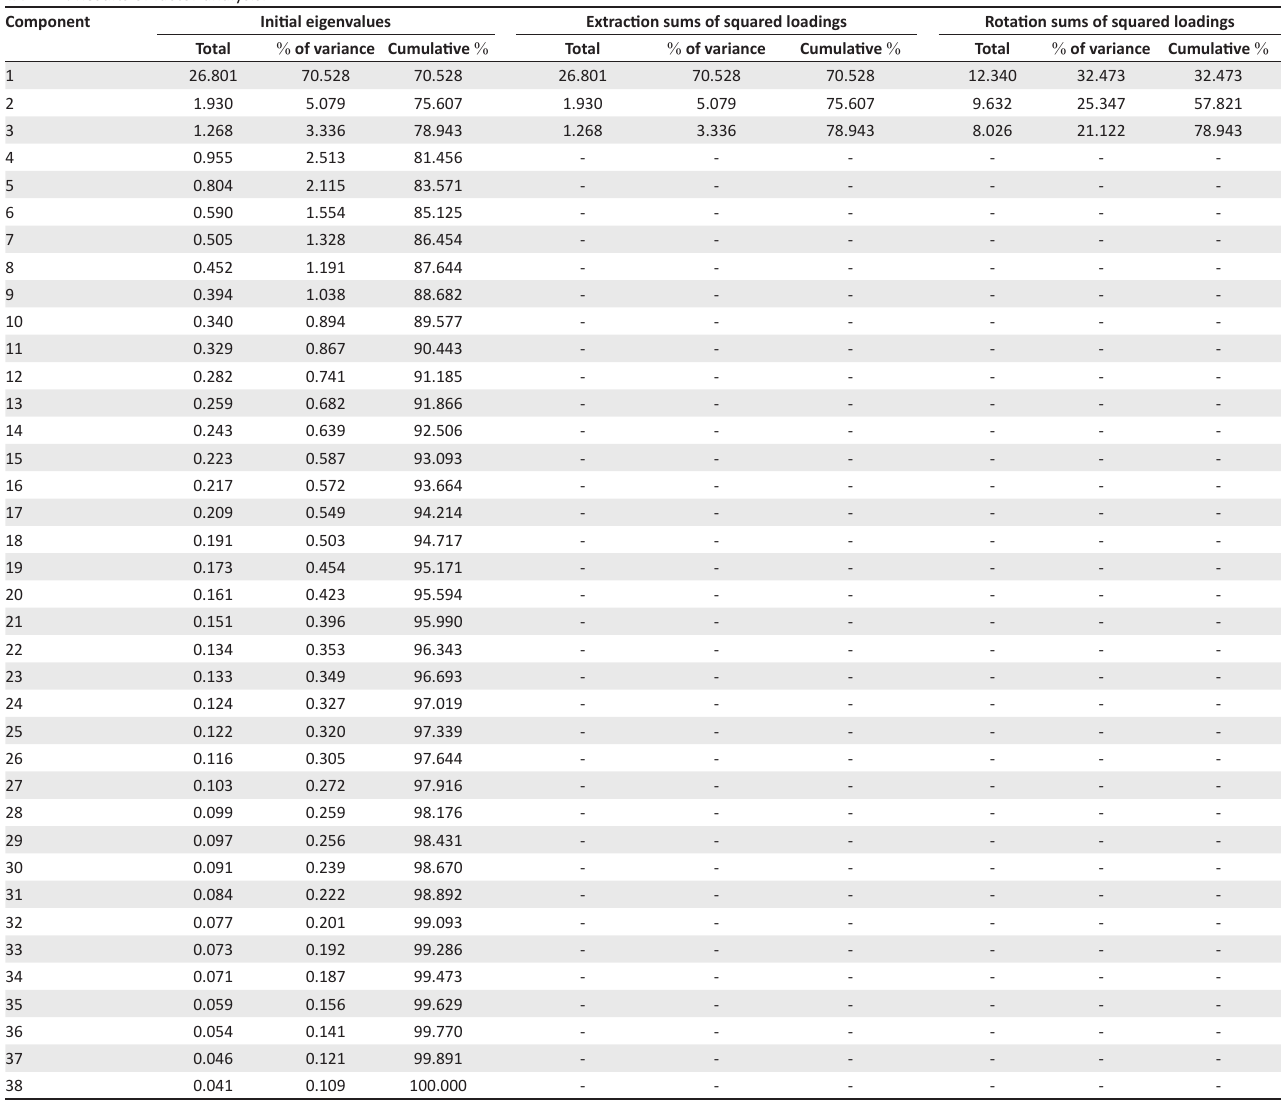
TABLE 1: Results of factor analysis.